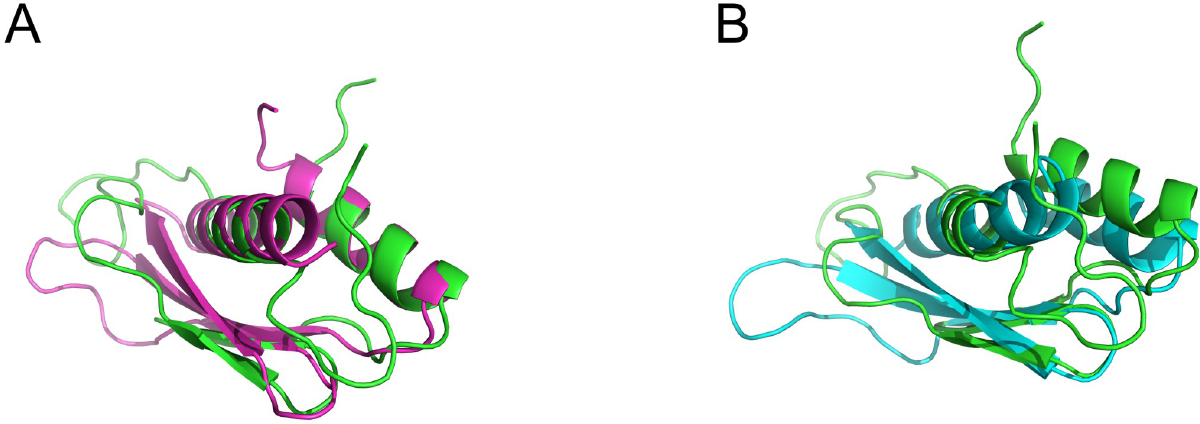
Fig 12. Dysferlin C2F β 6–7 subdomain aligned with known dsRNA binding domains. A. Superimposed β 6–7 subdomain of Dysferlin C2F (green) and RNA binding domain of Staufen (1STU) in cyan; RMSD = 2.7 Å . B. Superimposed β 6–7 subdomain of Dysferlin C2F (green) and dsRNA binding domain of TARBP2 (4WYQ) in magenta; RMSD = 0.86 Å